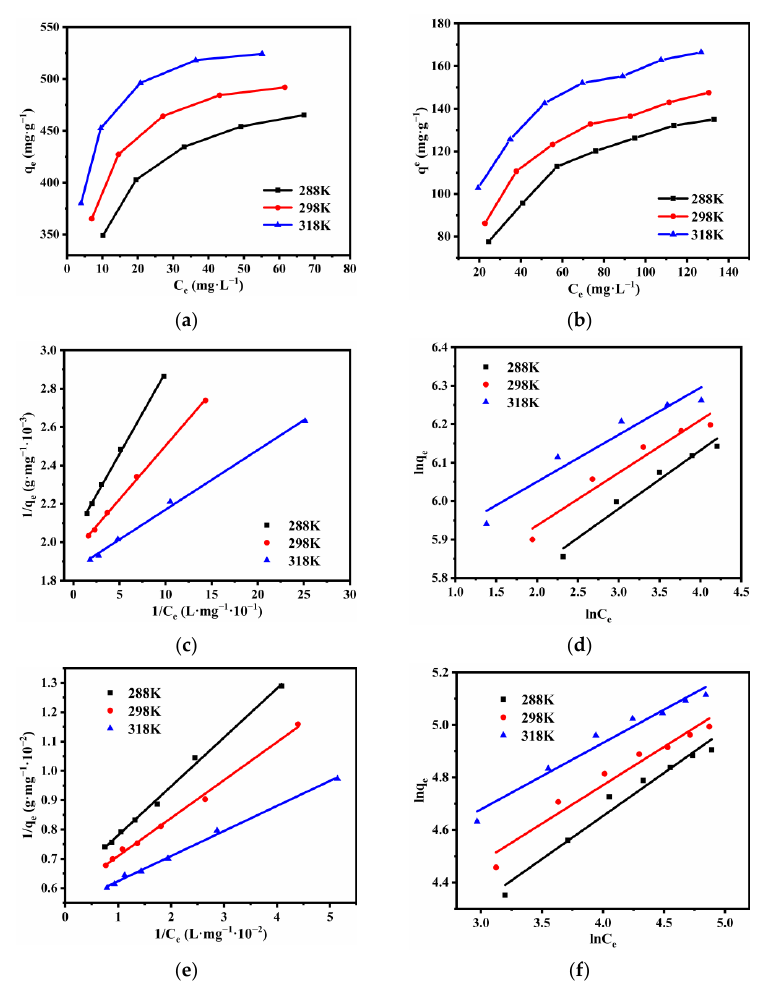
Figure 15 . The equilibrium adsorption of Pb( II ) ( a ) and Cu( II ) ( b ); the Langmuir isotherm model Figure 15. The equilibrium adsorption of Pb(II) ( a ) and Cu(II) ( b ); the Langmuir isotherm model fitting for the Pb( II ) ( c ) and Cu( II ) ( e ) removal process; the Freundlich isotherm model fitting for the fitting for the Pb(II) ( c ) and Cu(II) ( e ) removal process; the Freundlich isotherm model fitting for the Pb( II ) ( d ) and Cu( II ) ( f ) removal process. Pb(II) ( d ) and Cu(II) ( f ) removal Table 9. The corresponding parameters of the adsorption isotherm fitting.